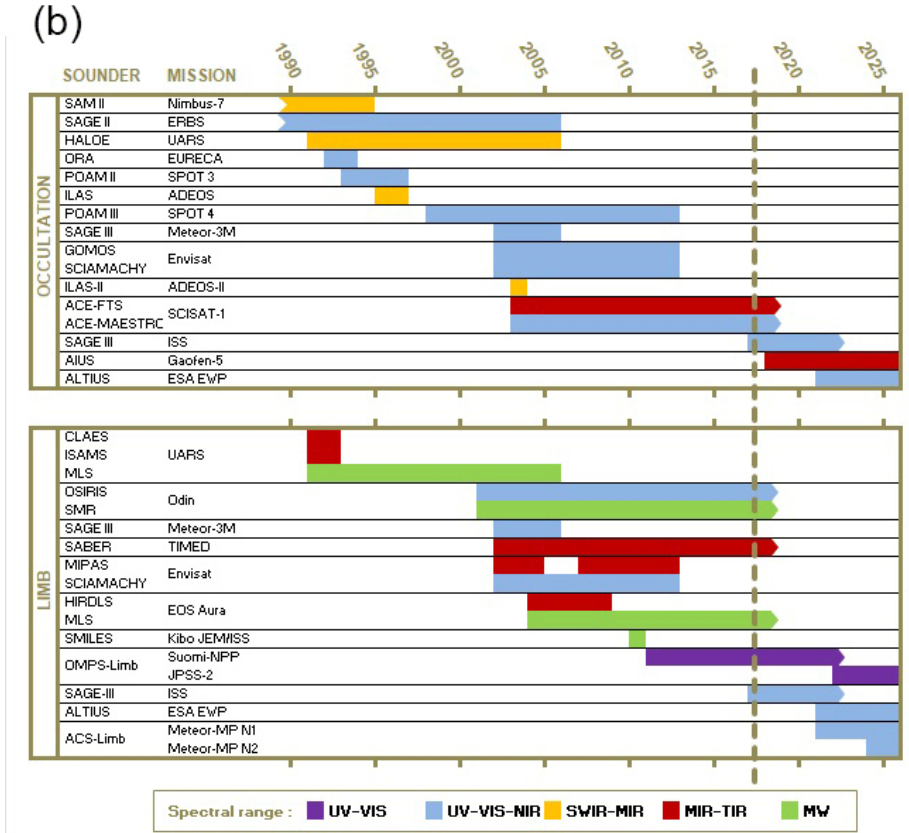
Figure 6. (a) Low earth orbit nadir-viewing satellite sounders supported by NDACC, from the inception of the NDSC through to the present day and beyond. Upper chart: backscatter UV (O 3 ) and UV/VIS (O 3 , NO 2 , BrO, HCHO, etc.) Lower chart: backscatter NIR/SWIR (near- infrared/shortwave infrared) (typically CH 4 , CO, H 2 O, N 2 O) and MIR/TIR (middle infrared/thermal infrared) emission (O 3 , CH 4 , CO, N 2 O, H 2 O, HNO 3 , HCl, CFC-11, CFC-12, etc.). (b) Low earth orbit limb-viewing satellite profilers supported by NDACC, from the inception of the NDSC through present day and beyond. Upper chart: solar (and stellar) occultation instruments measuring in the UV/VIS/NIR (typically O 3 , NO 2 , BrO, H 2 O, aerosols, etc.) and the MIR/TIR (typically O 3 , NO, NO 2 , HNO 3 , CH 4 , CO, H 2 O, CFC-11, CFC-12, aerosols, etc.). Lower chart: limb-scanning instruments measuring scattered light solar radiation (typically O 3 , NO 2 , H 2 O, aerosols, etc.), MIR/TIR emission (typically O 3 , NO, NO 2 , HNO 3 , N 2 O, CH 4 , CO, H 2 O, HCl, ClONO 2 , CFC-11, CFC-12, aerosols, etc.), and MW emission (typically O 3 , HCl, ClO, N 2 O, H 2 O, HNO 3 ,